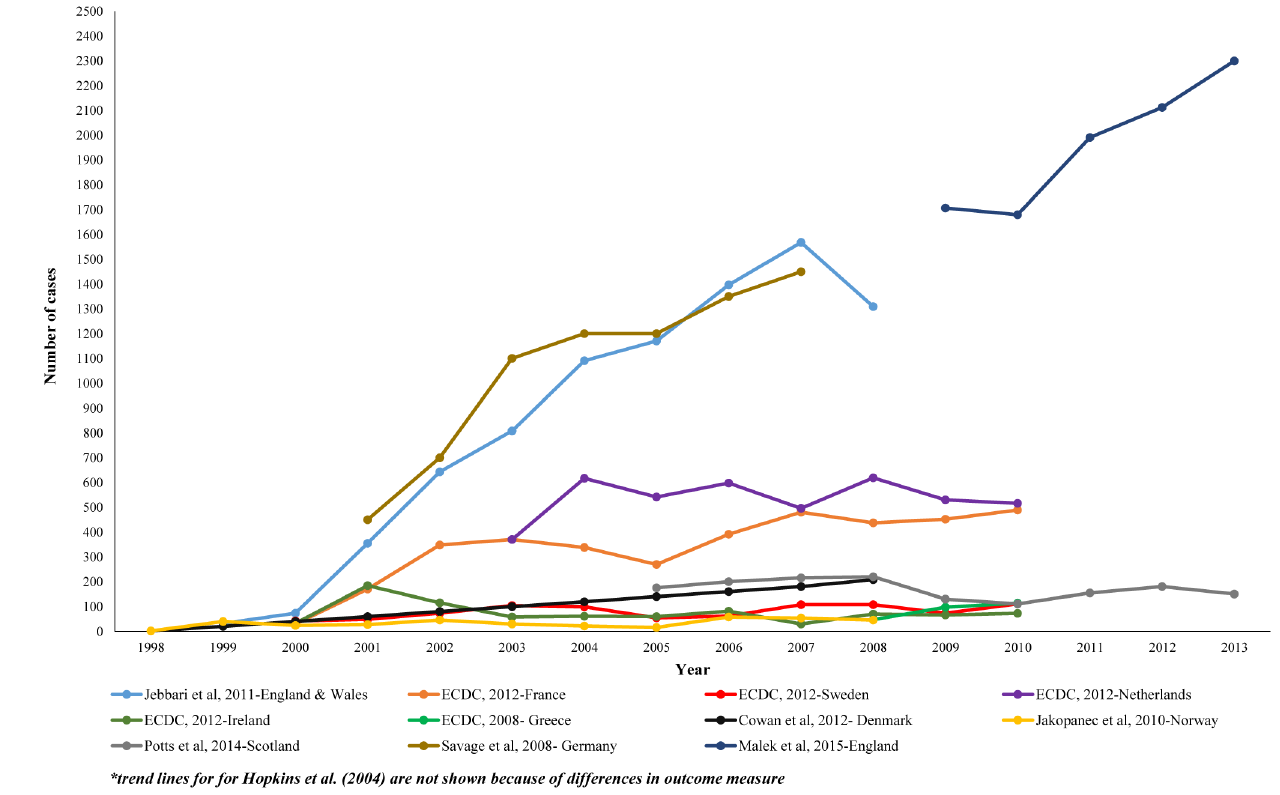
Fig 3. Syphilis trend studies in Western Europe: annual number of syphilis cases among MSM, 2004 – 2015.